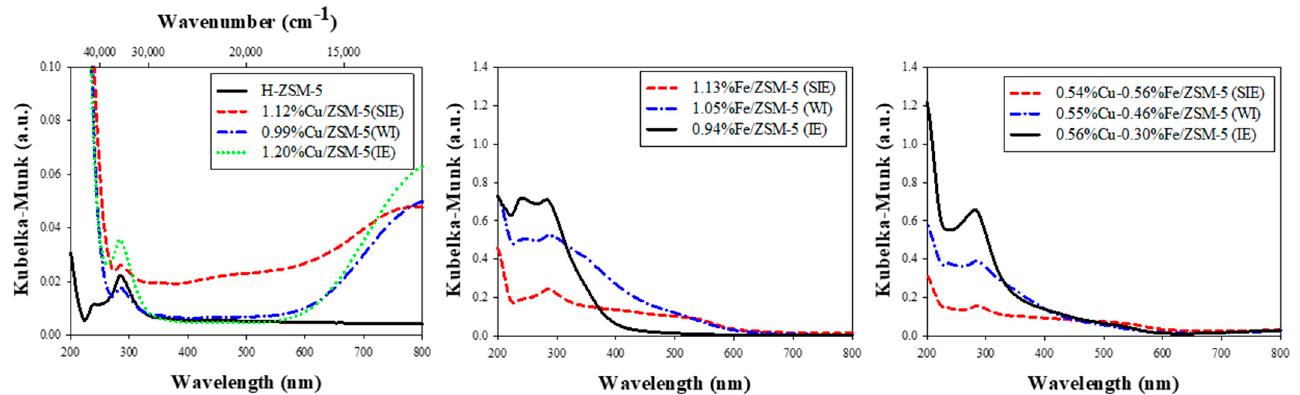
Figure 1. UV-Vis spectra of the catalysts prepared with different methods.